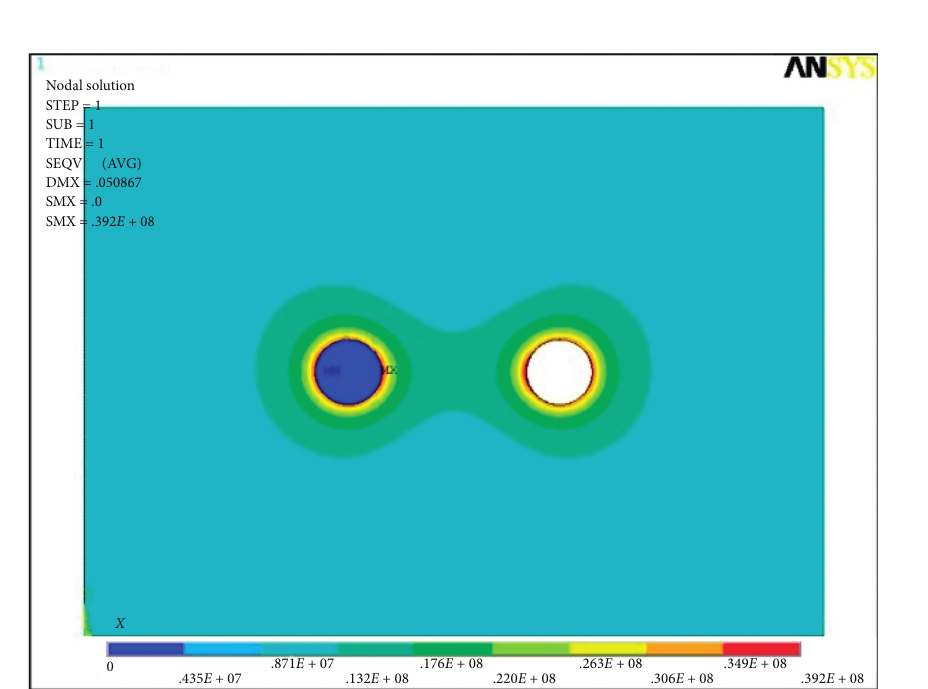
Figure 2: Cloud chart of stress distribution around the empty hole in the in situ stress